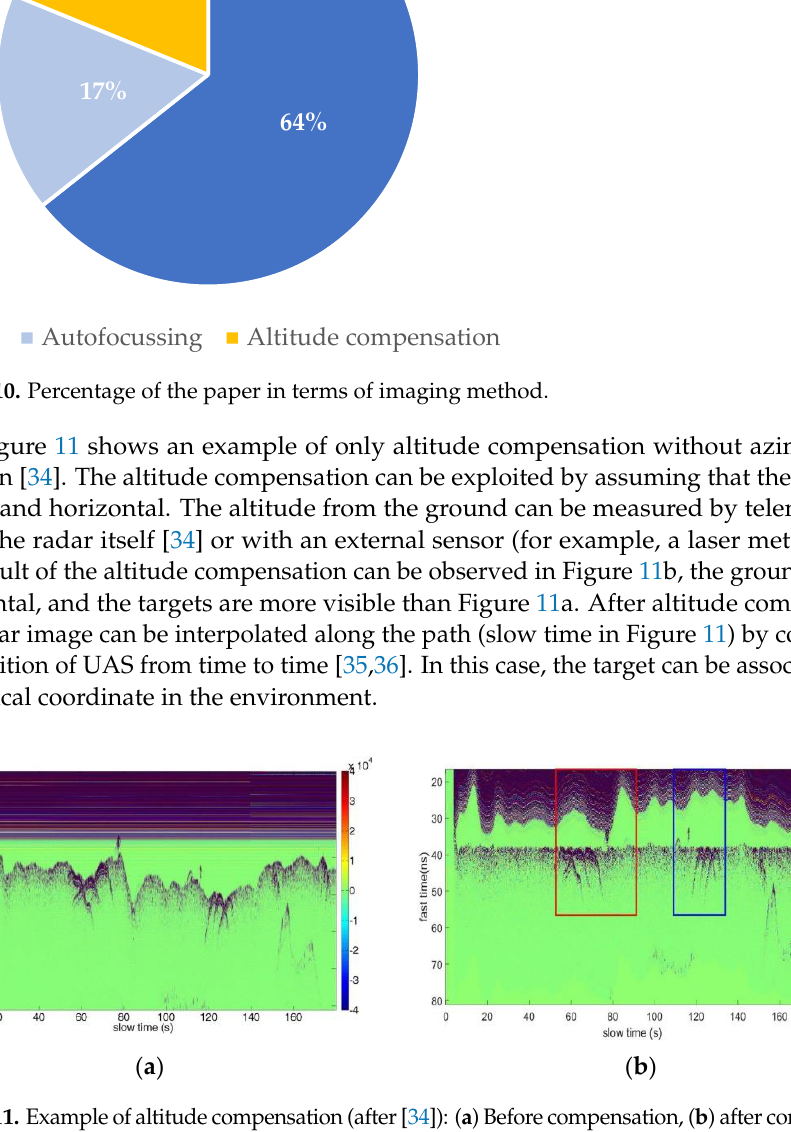
Figure 9. Number of papers in terms of operative bandwidth.